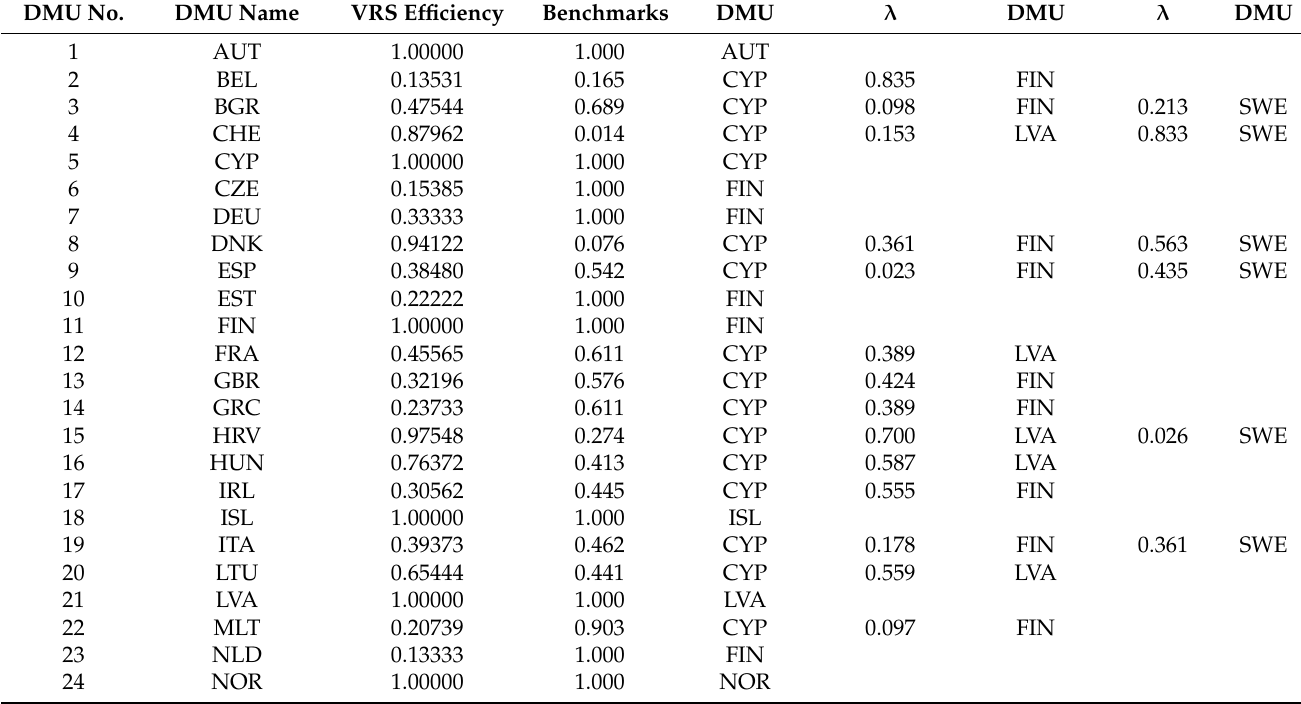
Table A6. Input-Oriented VRS Efficiency of EPS in 2012. Source: Authors’ calculations in DEAFrontier. DMU